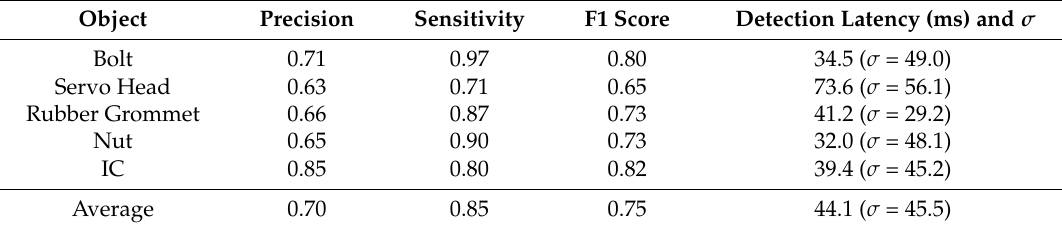
Table 1. Algorithm average results for precision, F1 score, Sensitivity, and Latency ( δ = standard deviation).